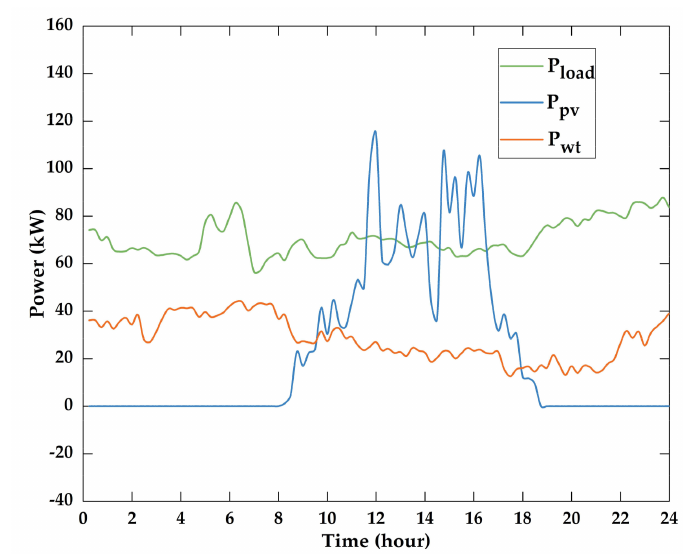
Figure 14. Power in the microgrid.